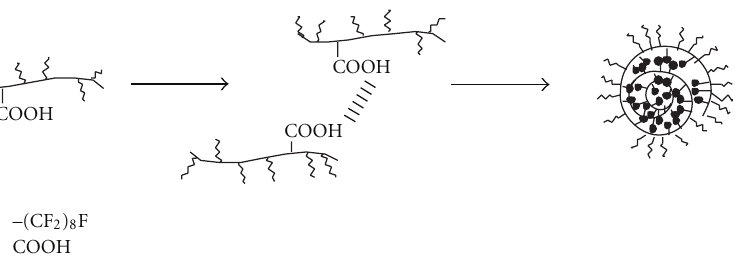
Scheme 4: A schematic of the formation of the spherical particles.